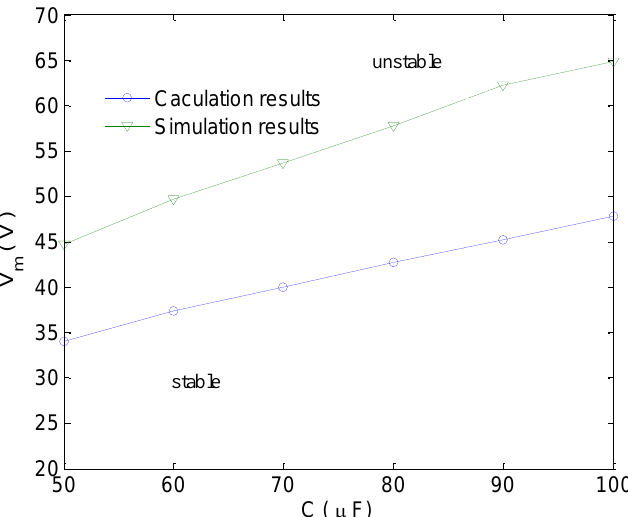
Figure 3. Stability boundaries of the input voltage obtained from the theoretical calculation and simulation experiment.